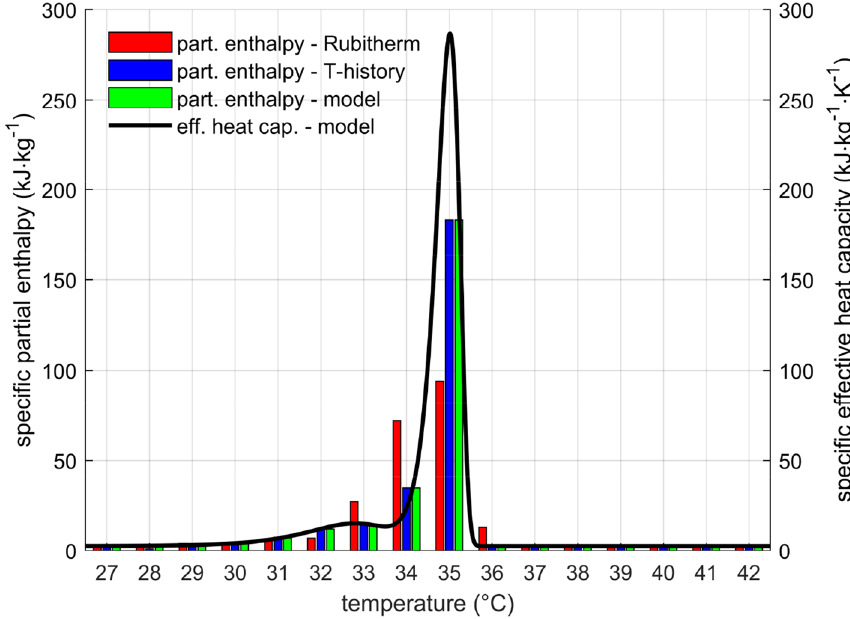
Figure 6. Partial enthalpy and specific effective heat capacity for solidification of RT35HC. Partial enthalpy and heat capacity are not the same, although the numerical values are often very close.